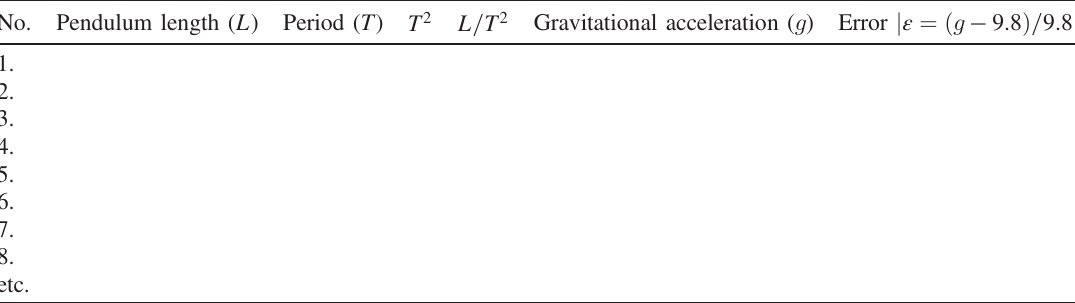
TABLE VII. Results for experiment II. No. Pendulum length ( L ) Period ( T ) T 2